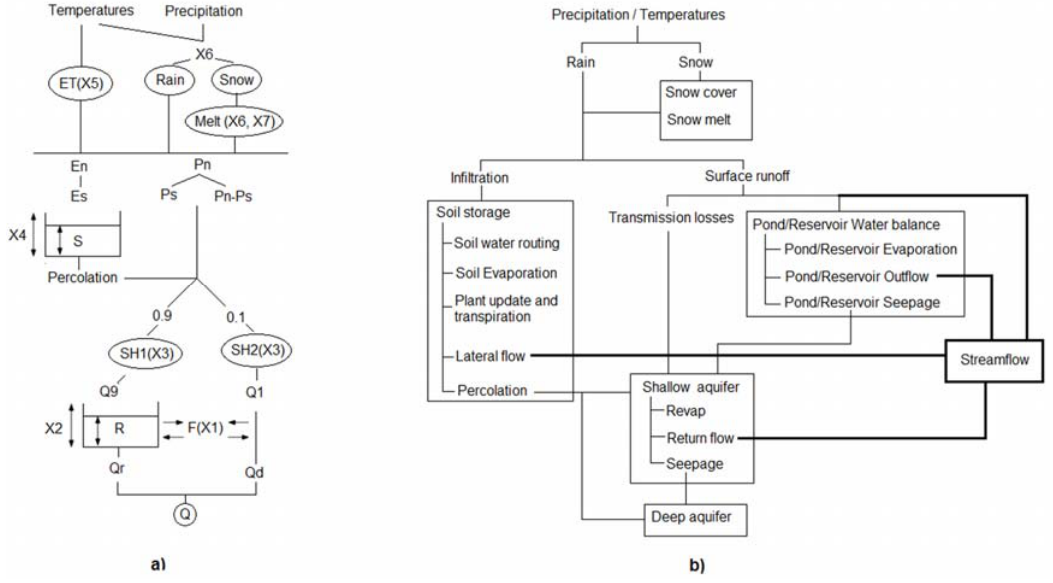
Figure 2. Schematic diagrams of the structure of the ( a ) GR4J model; and ( b ) SWAT model.